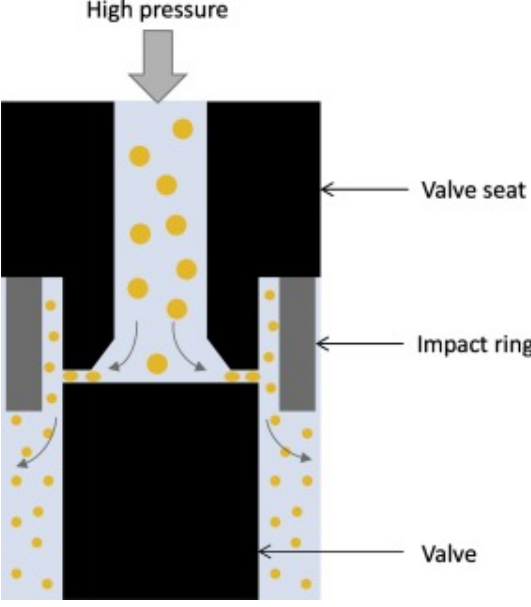
Figure 3. The high-pressure homogenizer with a standard homogenizing nozzle [8].